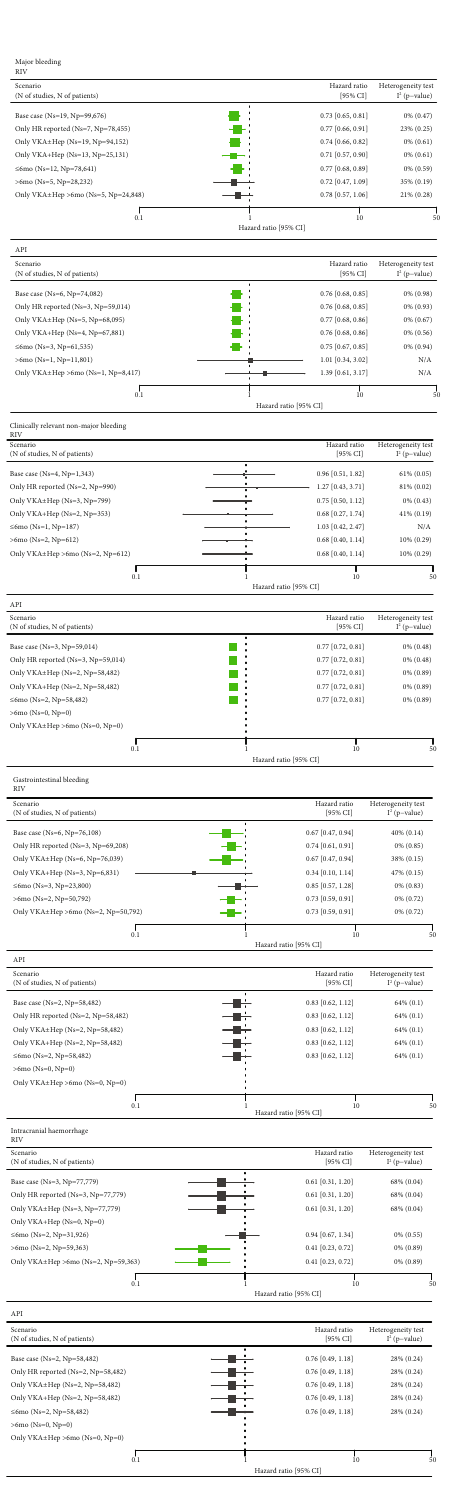
Figure 5: Summary of meta-analyses comparing RIV and API versus SoC in VTE for bleeding events. API: apixaban; CI: con fi dence interval; HR: hazard ratio; Np: number of patients; Ns: number of studies; RIV: rivaroxaban; SoC: standard of care; VKA ± Hep: vitamin K antagonist ± heparins; VTE: venous thromboembolism; N/A: not applicable. Green marks represent results indicating statistically lower event rate in the NOAC